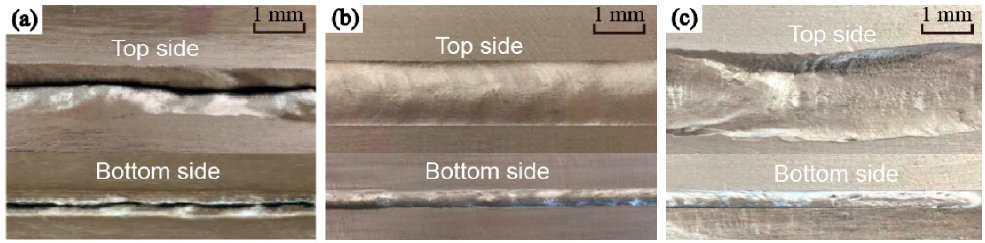
Figure 16. Schematic diagram of weld formations. ( a ) The weld was cut. ( b ) The weld formed well. ( c ) The weld collapsed .